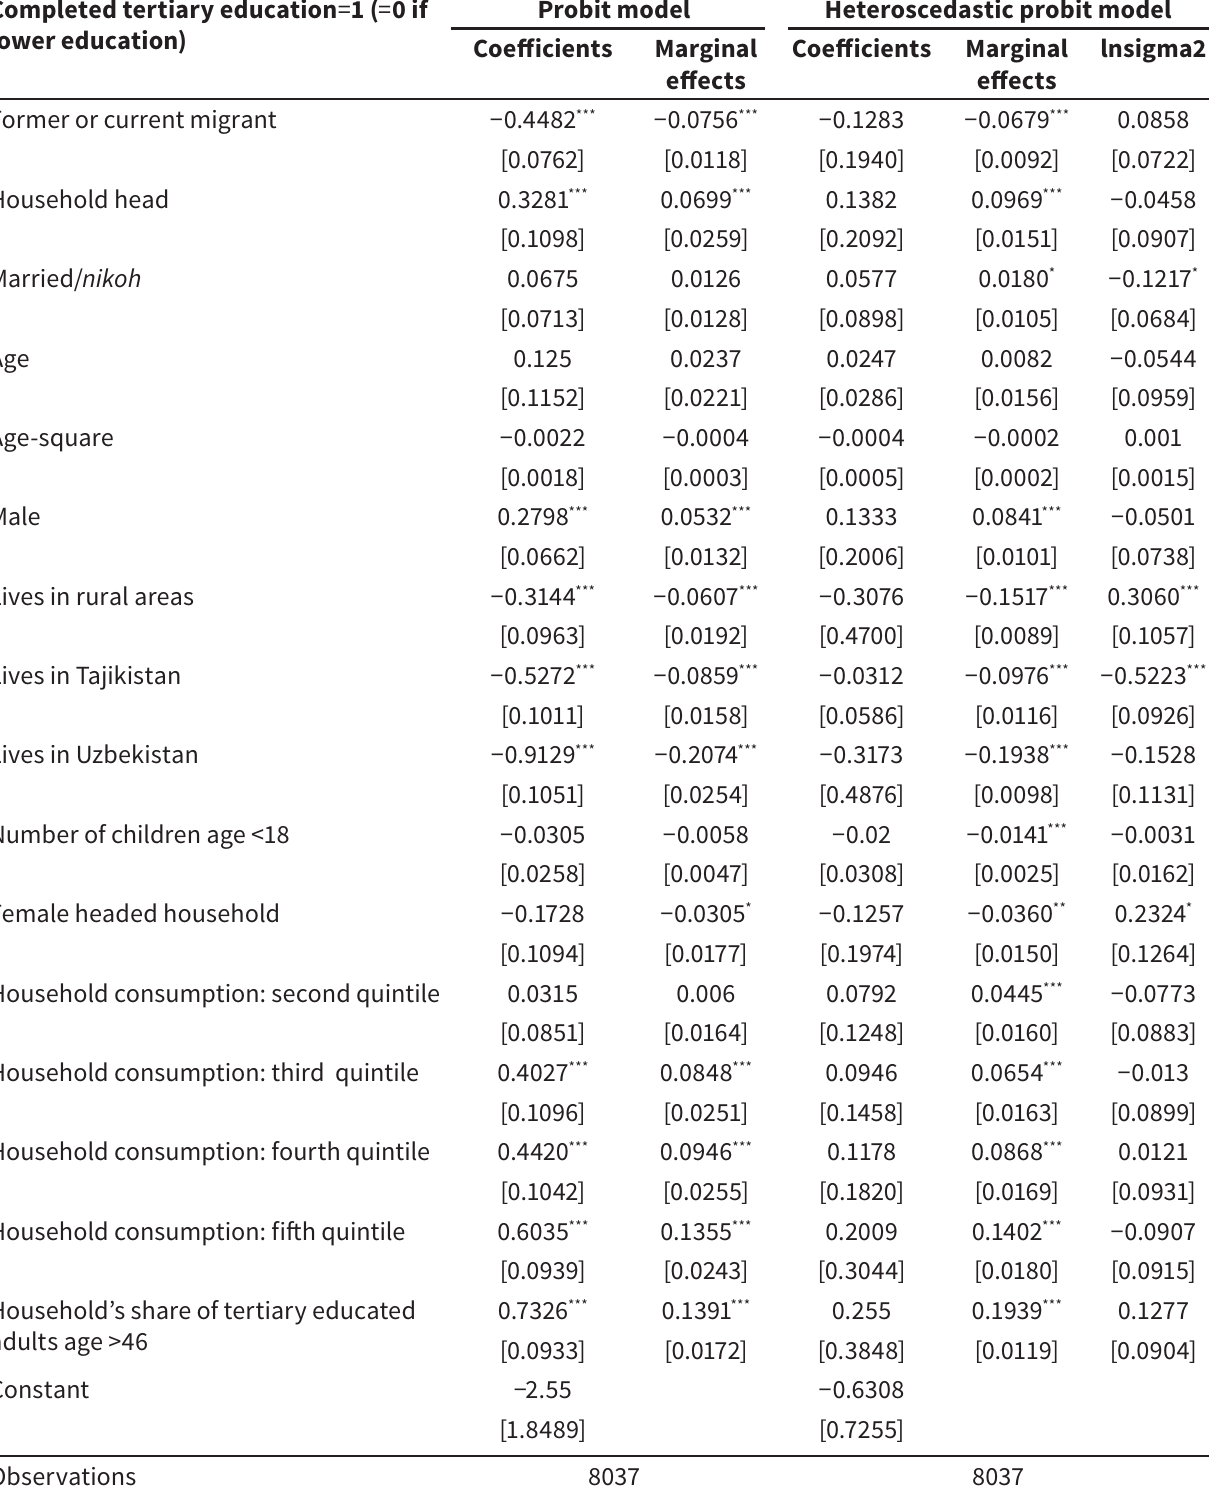
Probit and heteroscedastic probit regressions on decision of tertiary education Completed tertiary education = 1 ( = 0